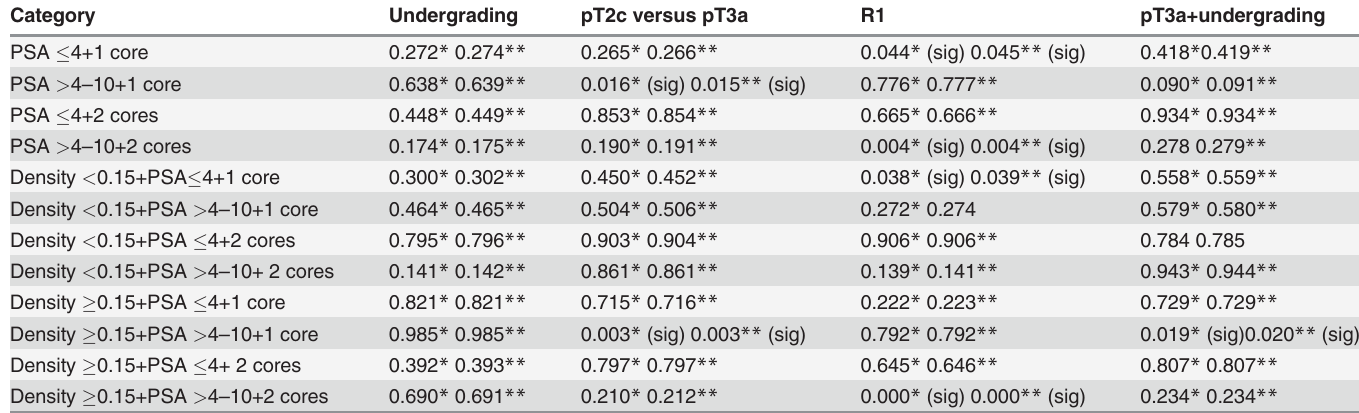
Table 5. Multivariate model; PSA levels (ng/ml) the number of positive biopsy cores and PSA density (ng/ml) for predicting worse fi nal pathological fi ndings; Statistics: * Chi-Quadrat Pearson; ** Fisher test. Category